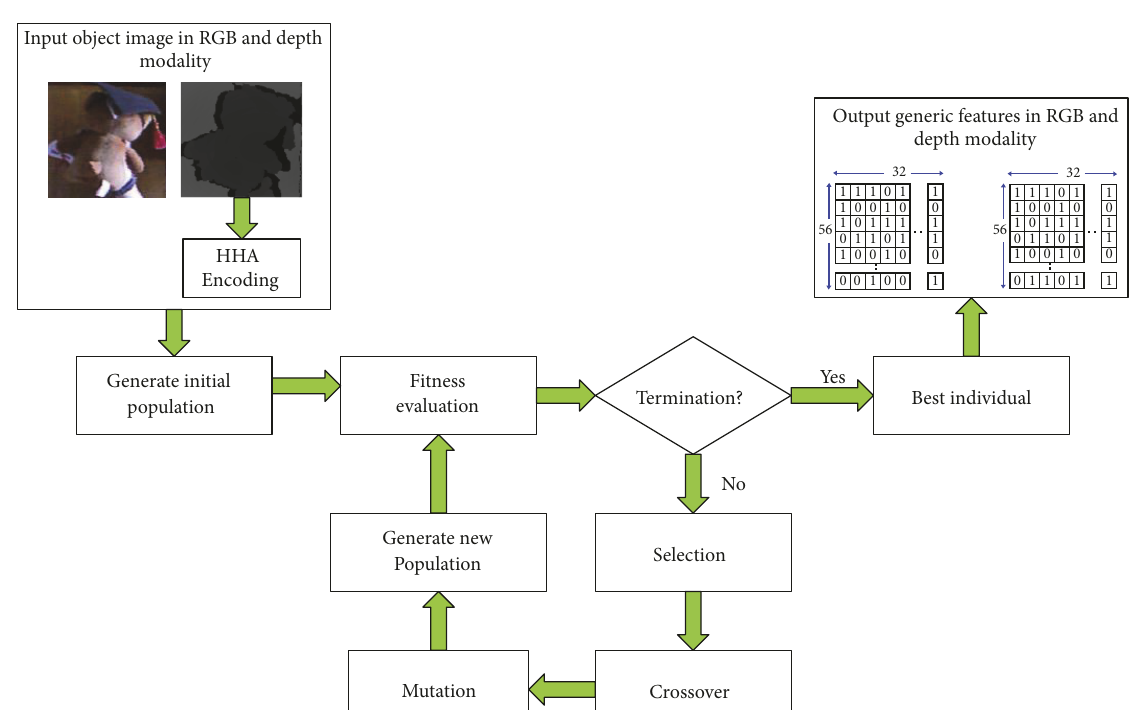
Figure 2: Flowchart shows how to calculate genetic feature in RGB and depth